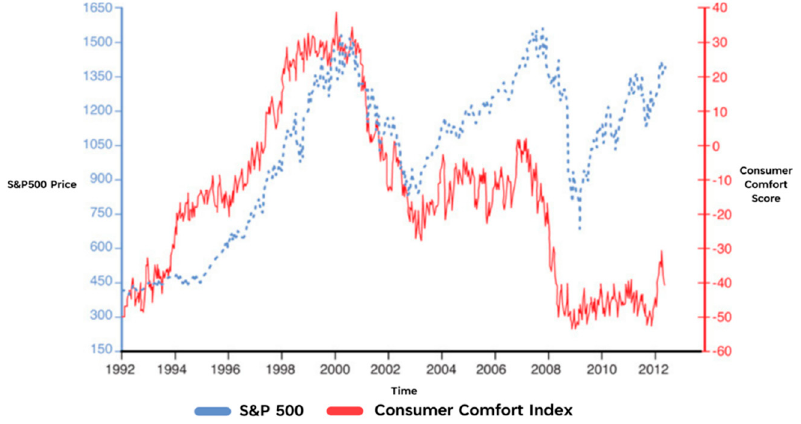
Figure 1. The Bloomberg Consumer Comfort Index versus the S&P 500 (in nominal terms), 1992–2012, [7].